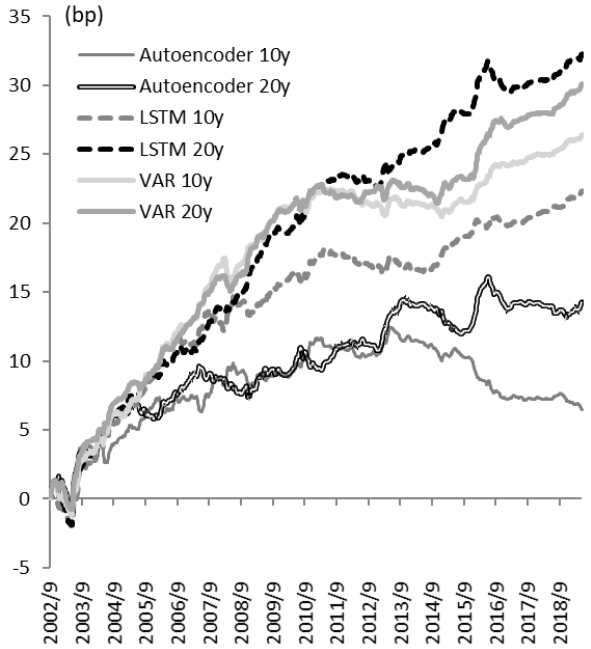
Figure 20. Cumulative returns from each investment strategy.